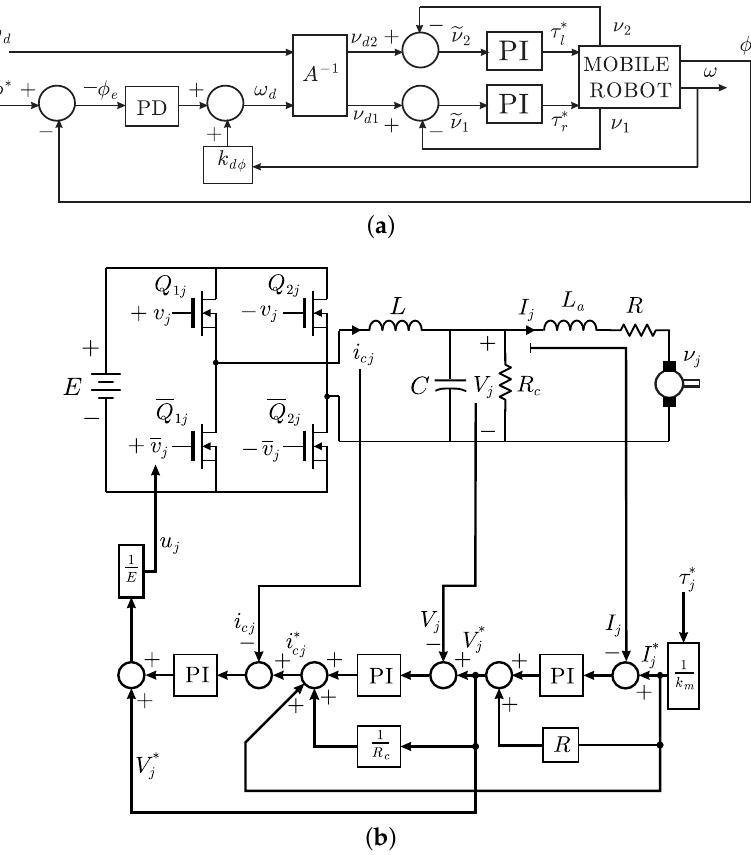
Figure 4. Block diagram of controller in Proposition 1. ( a ) PD path-tracking external loop and PI velocity loop. ( b ) Block MOBILE ROBOT in Figure 4a. Symbol τ ∗